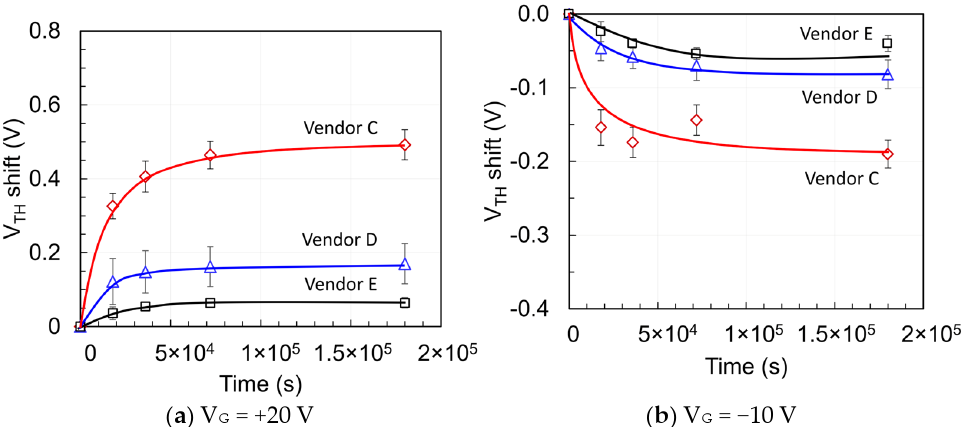
Figure 6. Threshold voltage shifts for ( a ) positive bias-stress of +20 V; ( b ) negative bias-stress of − 10 V for 50 h for commercial SiC MOSFETs. The error bars represent the spread of 5 devices measured for each vendor.